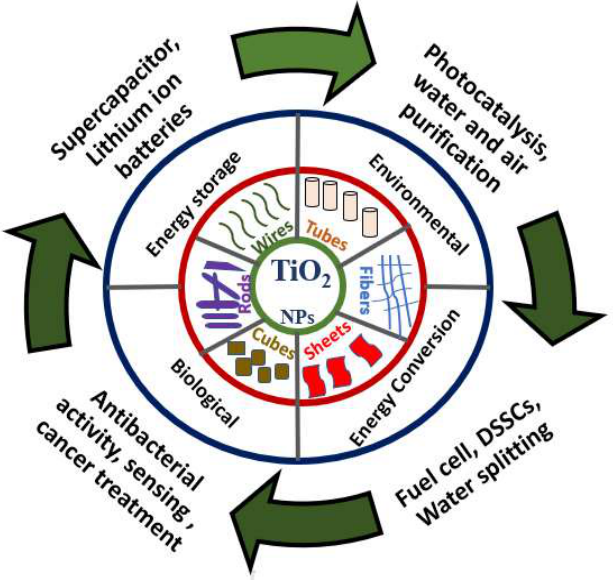
Figure 2. TiO 2 nanoparticles with distinct structures used in various applications.